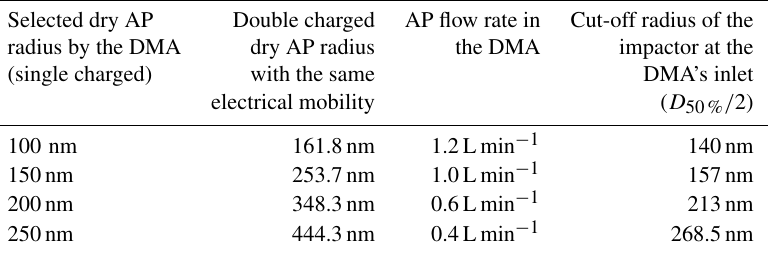
Table 2. AP selection parameters.